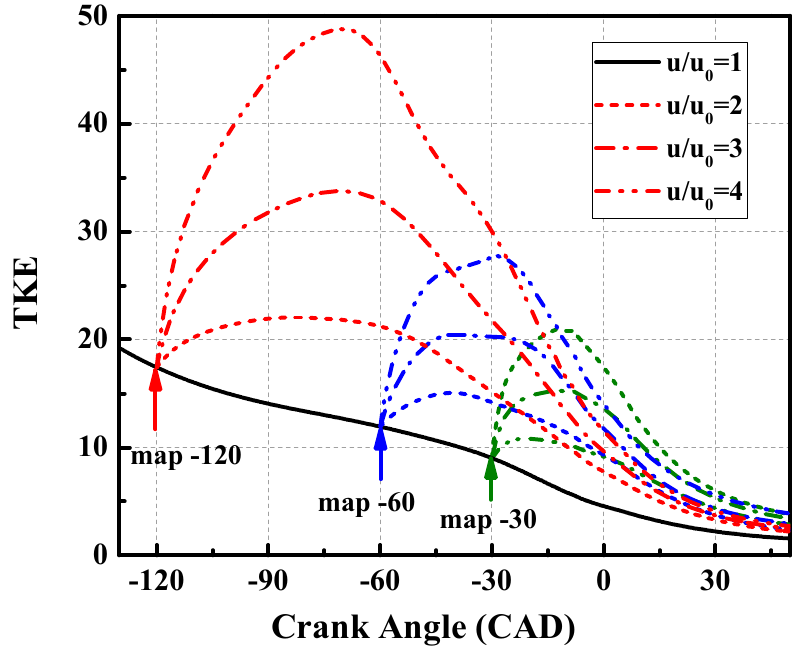
Figure 4. Evolution of averaged TKE after scaling the flow velocity at different times.